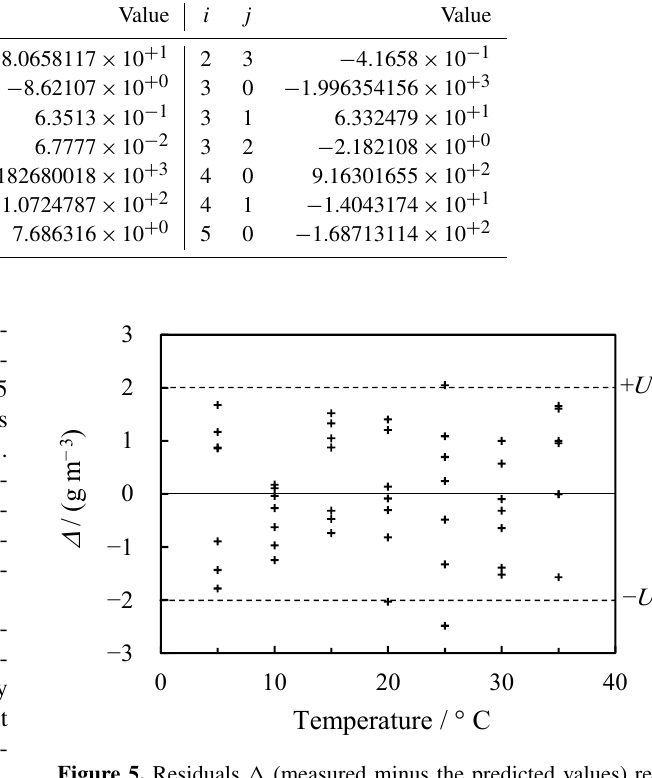
Figure 5. Residuals (cid:49) (measured minus the predicted values) re- (p 0 ) . U – uncertainty in the density– sulting from the fit of (cid:49)ρ SW 0 salinity